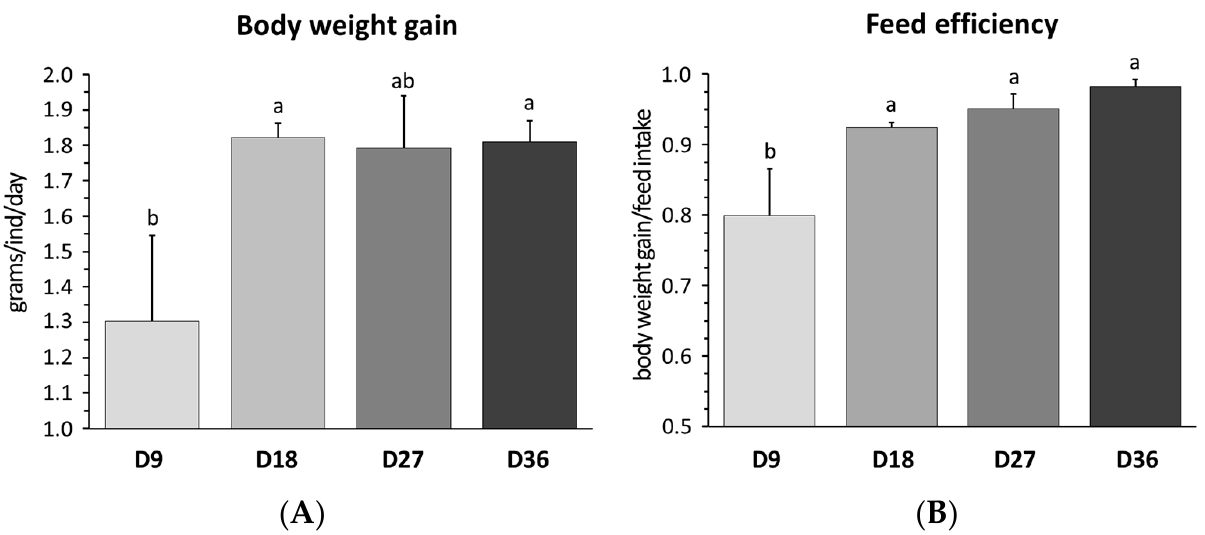
Figure 2. Body weight gain and Feed efficiency of rainbow trout hand-fed during 12 weeks with different stocking densities. ( A ) Representative body weight gain expressed in grams by individual at the end of the trial (12 weeks). ( B ) Representative feed efficiency expressed in body weight gain/feed intake at the end of the trial. One-way ANOVA followed by a post hoc Tukey’s test in case of significant differences ( p < 0.05, indicated with different letters. Mean values that do no share a common letter are significantly different).